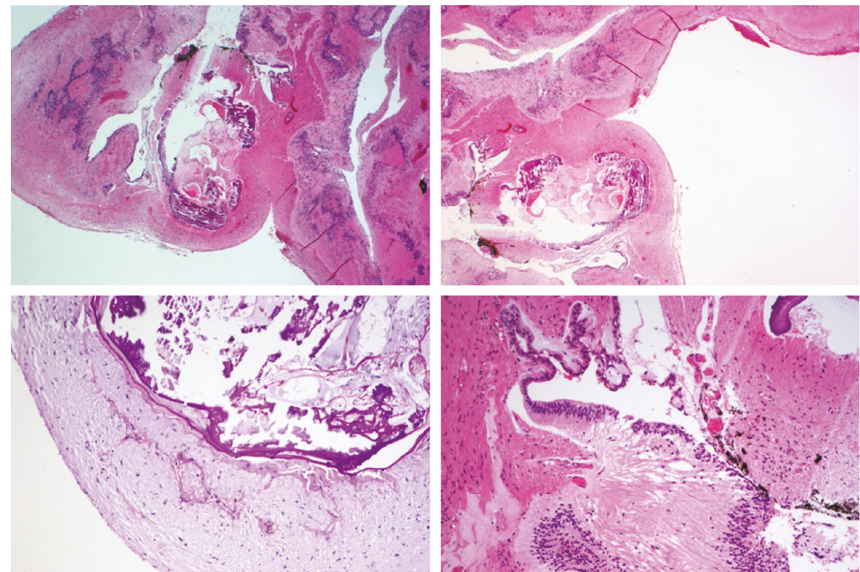
Figure 3: Histological examination of intracystal tissue. Magnification A , B : 20x; C , D : 100x. A , B and D : haematoxylin and eosin (H&E) staining; C : PAS